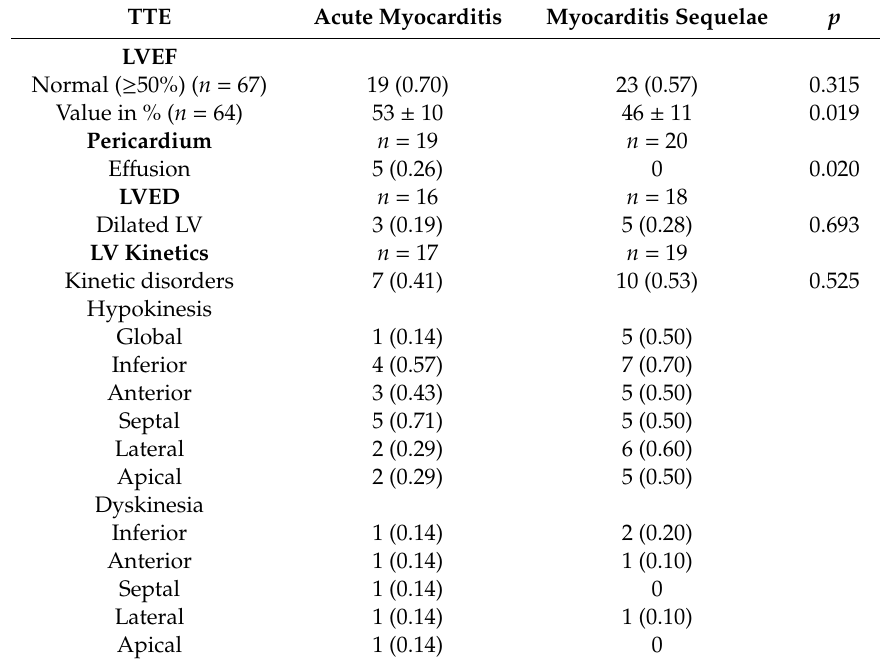
Table 3. Initial Transthoracic echocardiography (TTE) data. LV: left ventricle. LVED: left ventricular end-diastolic diameter.